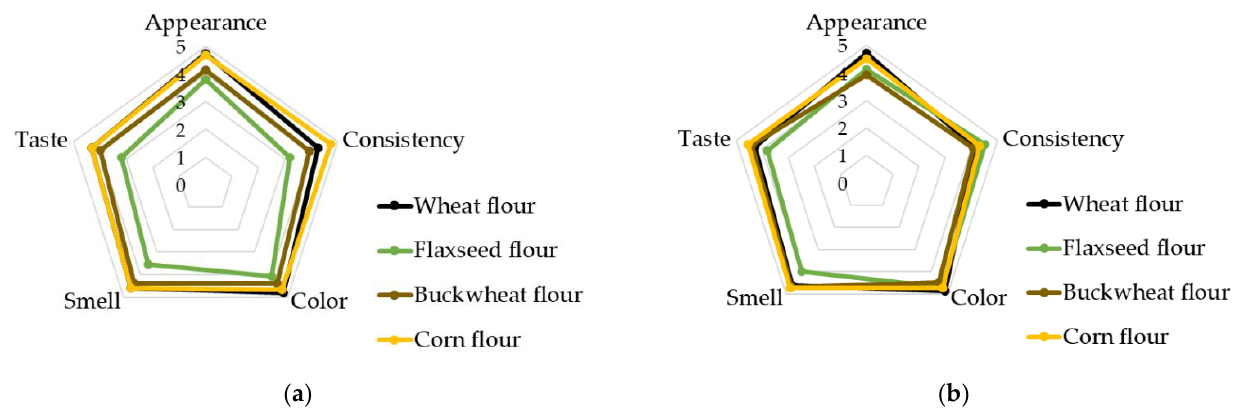
Figure 5. Sensory evaluation of the gingerbread samples for the samples prepared using the commercial glucose syrup ( a ) and the experimental glucose syrup ( b ).